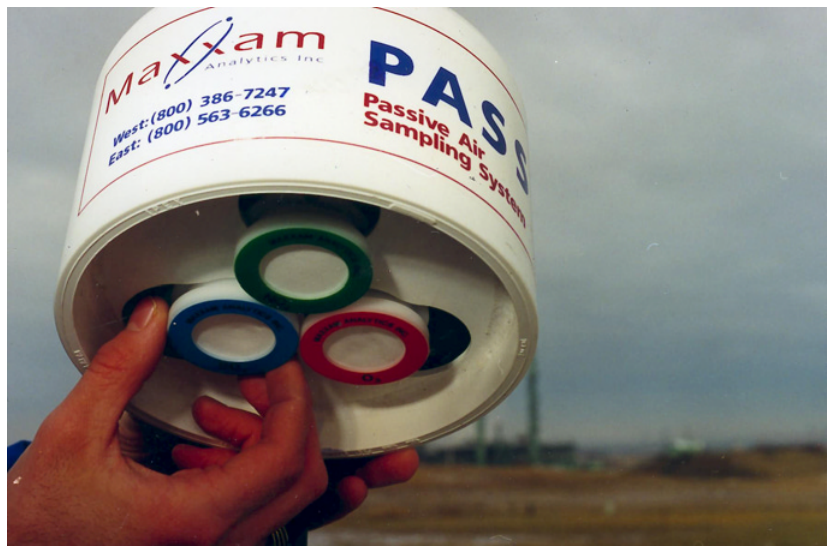
FIGURE 1. Passive samplers of Maxxam all-season passive sampling